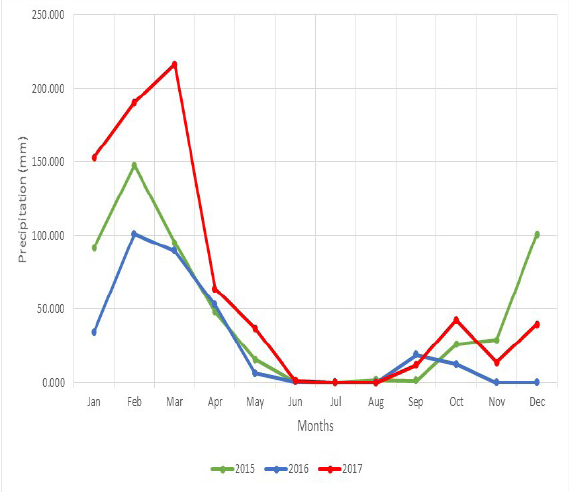
Figure 4. Comparison of accumulated monthly precipitation (mm) from 2015 to 2017. Source: Cajatambo CWS, SENAMHI.